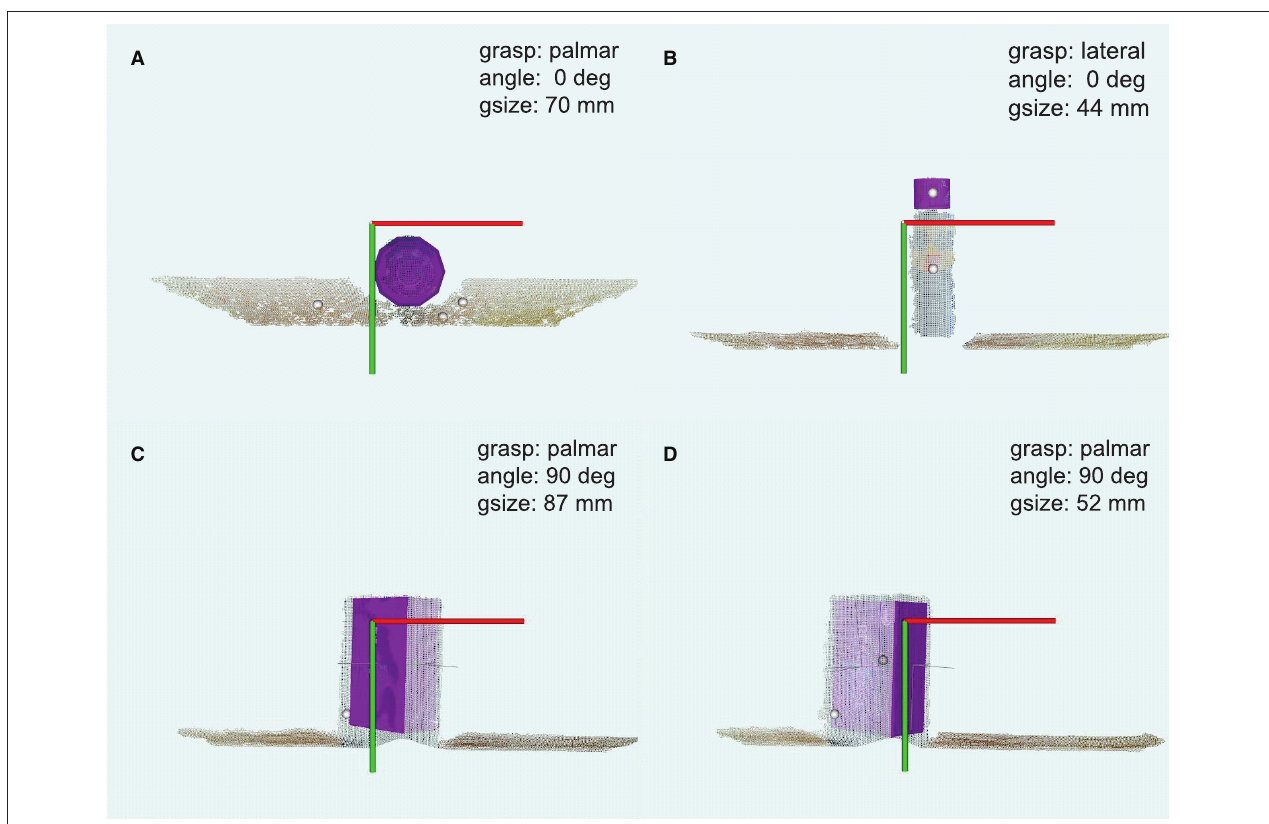
FIGURE 5 | Snapshots captured while grasping example objects in Phase I. The system correctly detected spherical, cylindrical and cube shaped objects or object parts. The point cloud centroids are rendered as small white spheres in the figures. The point cloud with the closest centroid to the Z’-axis of the hand/camera frame was selected for fitting (purple shape primitives). The user selected the ball (A) and plastic cap (B) by aiming at the vicinity of these objects. In (C,D) , the user marked different faces of the same cuboid object (highlighted shades). Each panel reports the selected grasp type, size, and wrist orientation. The coordinate frame represents the X’OY’ plane of the